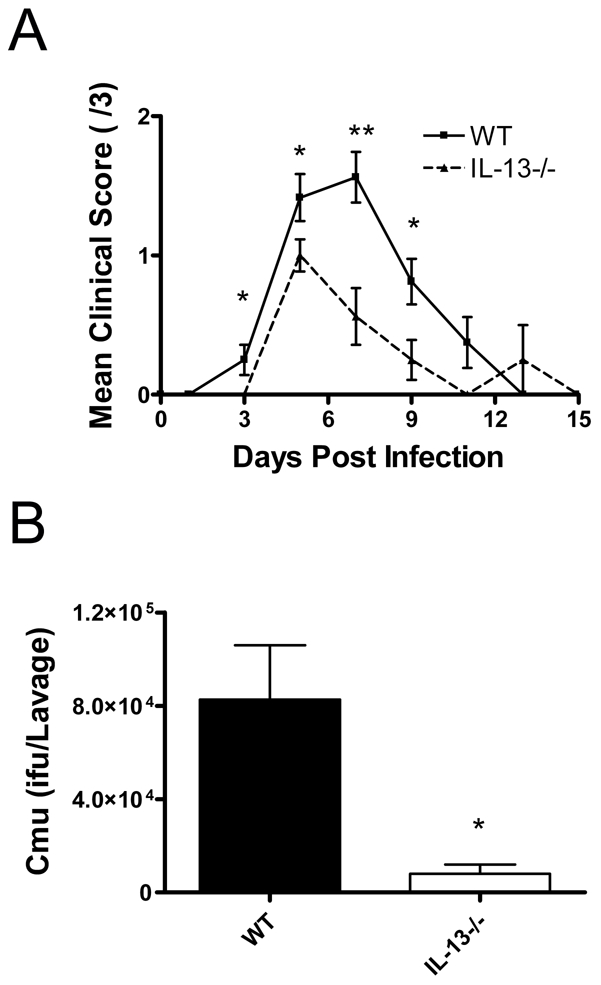
A role for IL-13 in Chlamydia muridarum (Cmu) genital tract infection.WT and IL-13−/− mice were infected intravaginally with 5×104 ifu of Cmu. (A) Cmu numbers in vaginal lavage fluid at day 15 were measured by quantitative real-time PCR and (B) clinical score assessed according to the criteria listed in Table 1 for 15 days post infection. Results are presented as mean ± SEM and significant differences between strains are shown as *p<0.05 and **p<0.01.